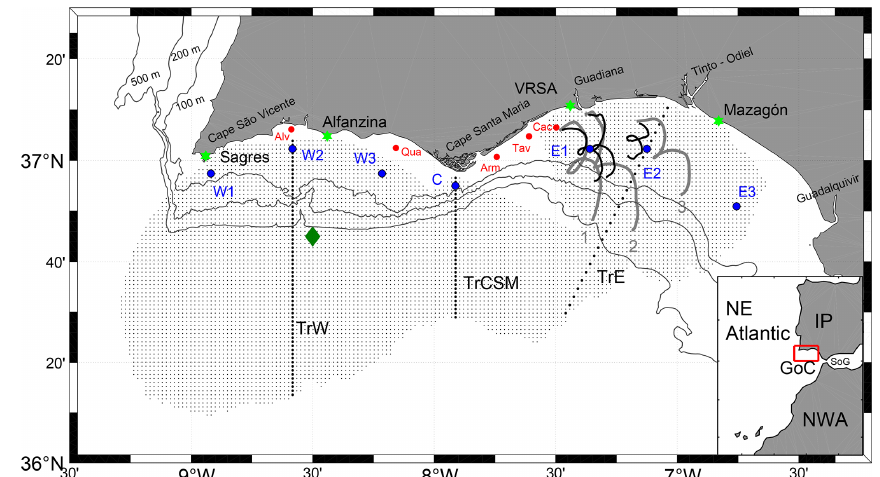
Figure 1. Study area with location of the HFR antennas (green stars, with VRSA: Vila Real de Santo António), ADCP mooring (red dots, with Alv: Alvor; Qua: Quarteira; Arm: Armona; Tav: Tavira; Cac: Cacela), HFR grid nodes with ≥ 60% of measurements (thin black dots) along with the transects (TrW, TrCSM and TrE indicated as thick black dots) and grid nodes (W1, W2, W3, C, E1, E2, E3, thick blue dots) analysed in the study. The thick grey and black lines represent the drifters’ trajectories and corresponding PVD from HFR data, respectively (see Sect. 4). The dark green diamond indicates the point where wind from ERA5 reanalysis was extracted (Sect. 6.1). The isobaths of 100, 200 and 500m are represented as thin black lines. For general location, see inset (IP: Iberian Peninsula; NWA: northwest of Africa; GoC: Gulf of Cádiz; SoG: Strait of